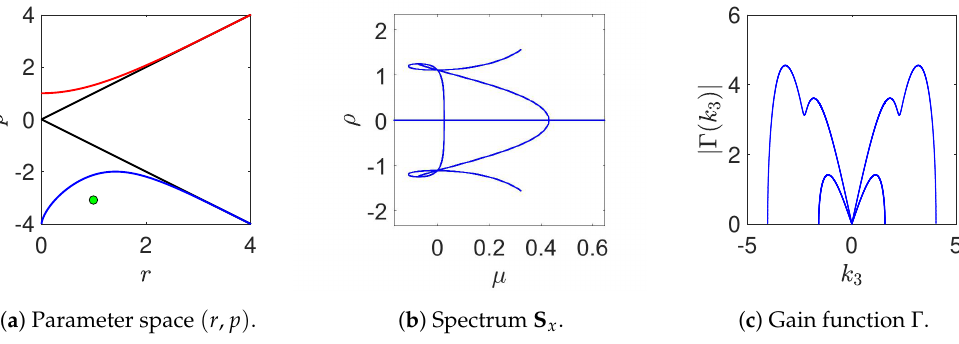
Figure 6. The spectrum S x 0G 2B 0L and gain function Γ for r = 1, p = − 3.1